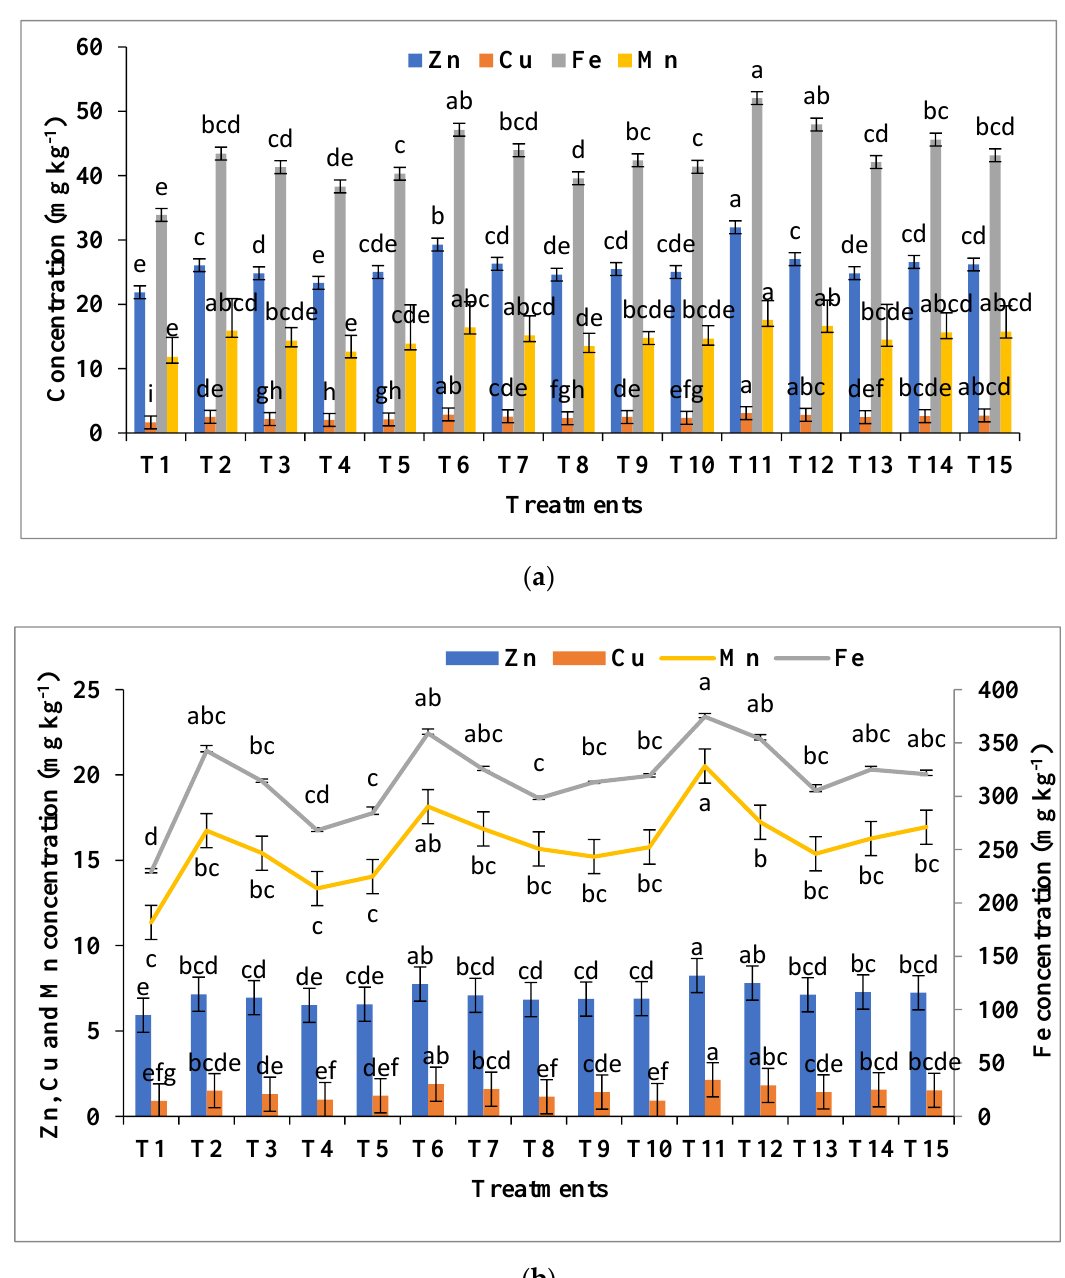
Figure 3. Effect of different fertilizers and manures on micronutrient concentration (Zn, Cu, Fe and Mn) in ( a ) grain and ( b ) straw of wheat. Treatment details are given in Table 1. The bar with similar or dissimilar letter(s) was evaluated with the least significant difference (LSD) multiple range tests using a probability level of p ≤ 0.05.